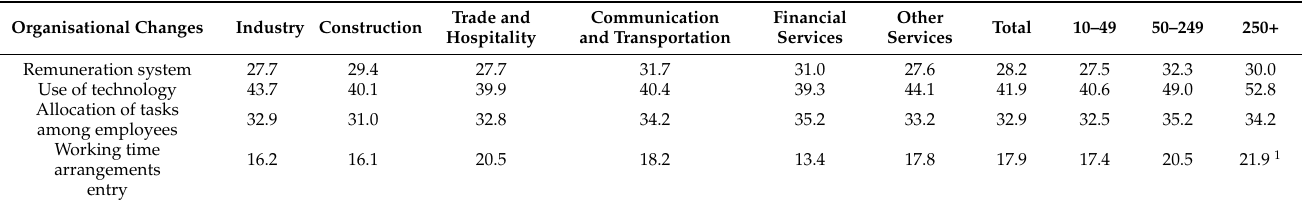
Table 1. Organisational changes in EU-28 working centres during 2010–2013, according to activity sector and workforce size (in percentage).